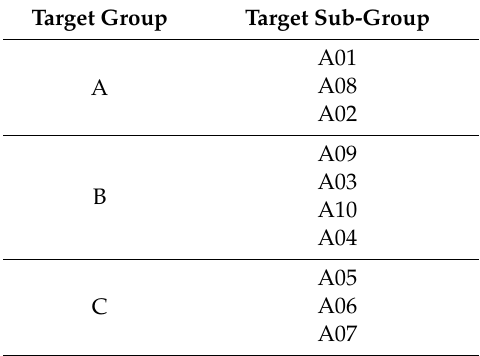
Table 4. Clustering results of target groups.